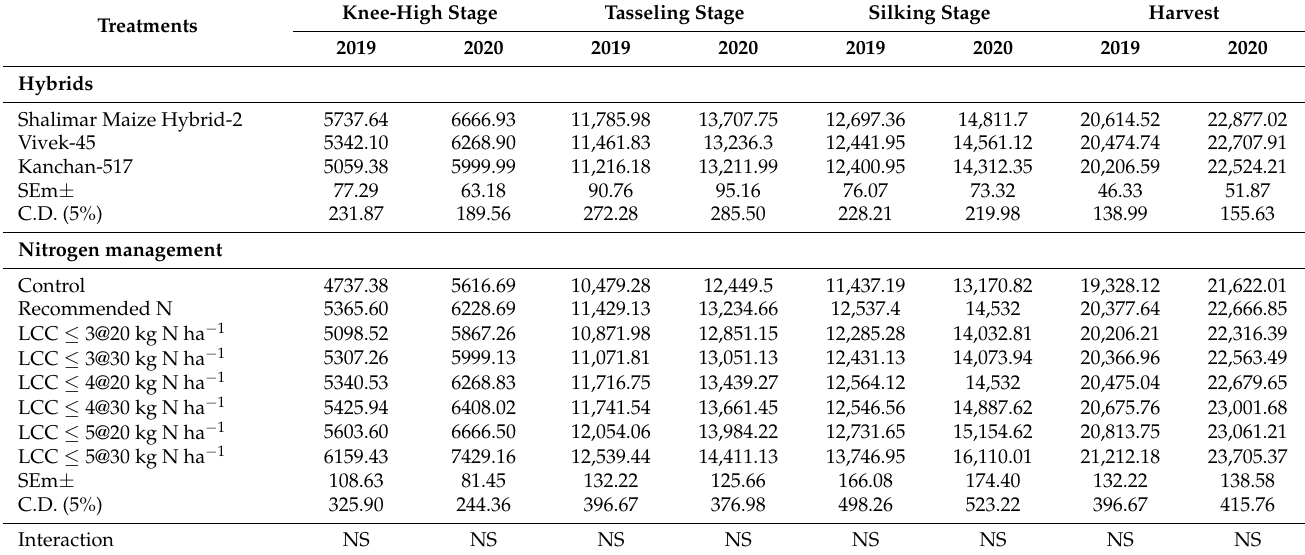
Table 5. Effect of precision nitrogen management through LCC on Heliothermal ( ◦ C day hour) units of different hybrid maize genotypes.